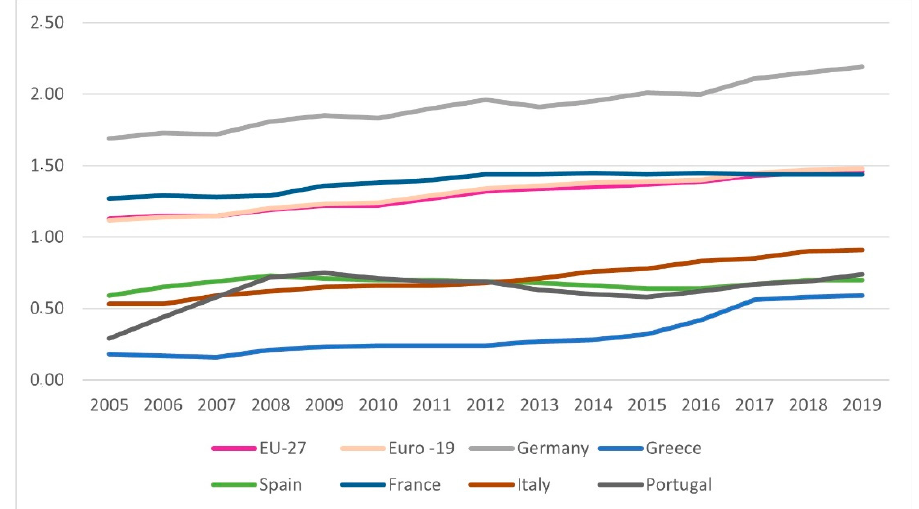
Figure 1. R&D Expenditures (total-%GDP)/Source: Eurostat, own calculations.